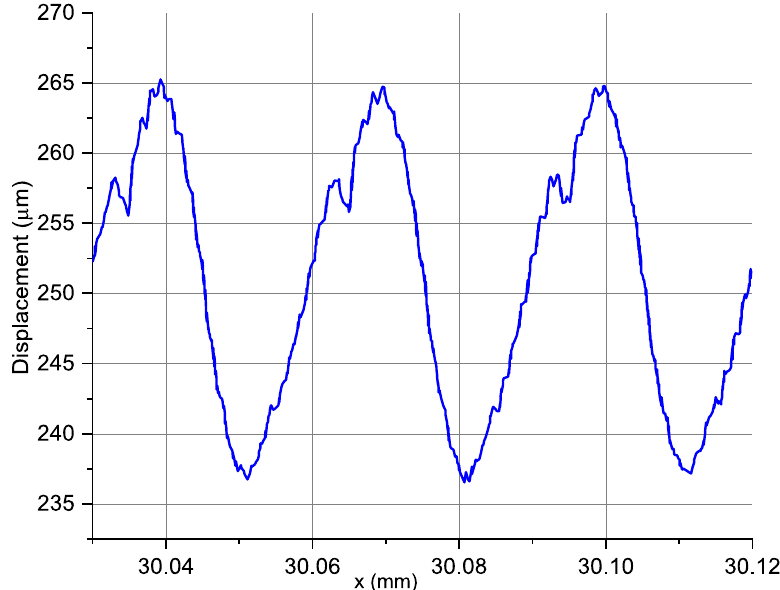
Figure 5. Example of signal slice after trend removal: vc = 360 m/min, f = 0.03 mm/rev; ap = 0.35 mm; r n = 48.6 μ m; n = 2460 rpm.